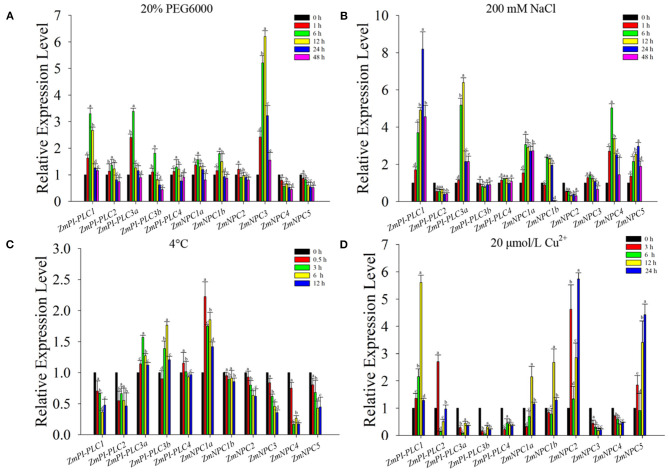
Quantitative real-time PCR analysis of ZmPLCs expression under stress treatments: (A) 20% PEG 6000, (B) 200 mM NaCl, (C) 4°C, (D) 20 μmol/L Cu2+. The expression levels were normalized to that of TUB. Bars represent SE (n = 3). The entire experiment was repeated three times. Different letters indicate values that departed significantly from those of without stress.